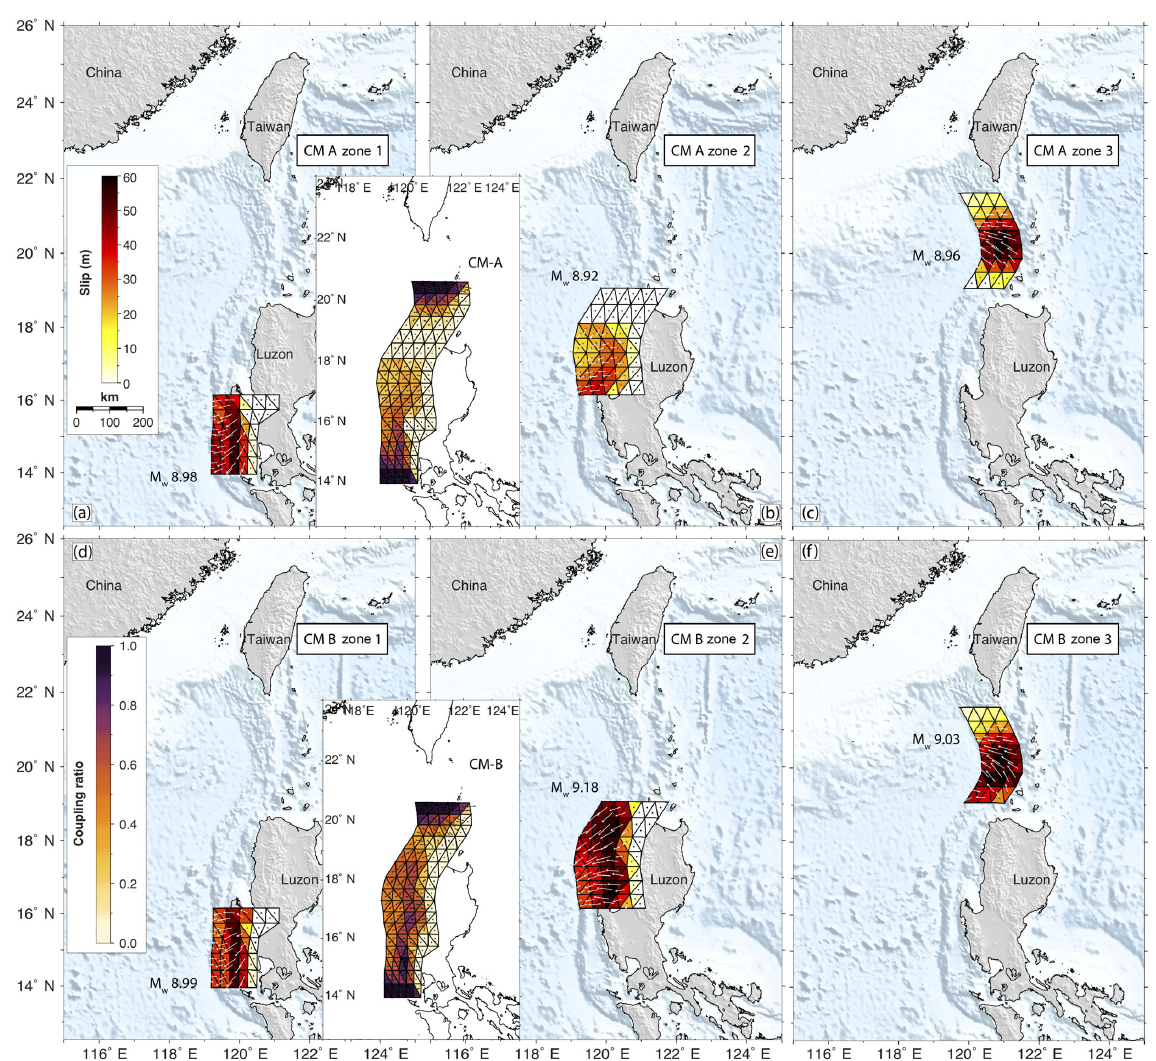
Figure 3. Proposed rupture slip models based on coupling models from Hsu et al. (2016) assuming a 1000-year seismic return time period. Panels (a) and (b) show the slip models from coupling model A (Hsu et al., 2016) in zones 1 and 2, respectively. Panel (c) shows a proposed hybrid model based on coupling model A (19 to 20 ◦ N) and a Gaussian shape of slip distribution (20 to 21.7 ◦ N) with a 50% coupling ratio in zone 3. Panels (d–f) represent the same slip models as (a–c) but based on coupling model B (Hsu et al., 2016). CM refers to coupling model. Coupling models A and B are from Hsu et al. (2016) that are shown in the inset map. White arrows show the possible slip directions during an earthquake. Vectors in the coupling maps show the slip deficit direction that is accumulated for future release in earthquakes. The estimated seismic moments of each model are labeled in each subplot with rigidity of 30GPa. The slip magnitude and coupling ratio are shown by its corresponding color